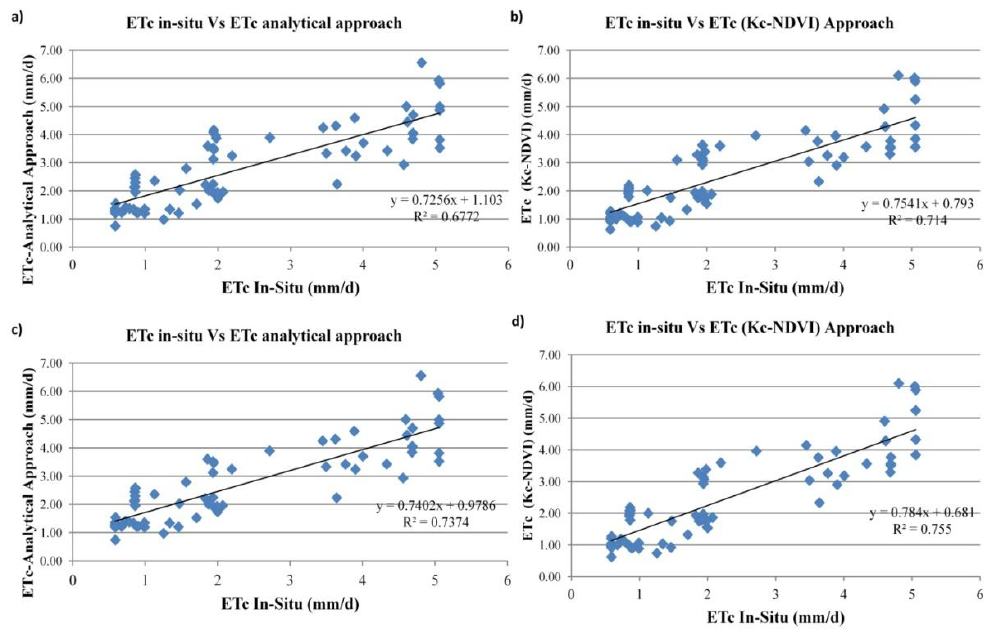
between estimates with the K c